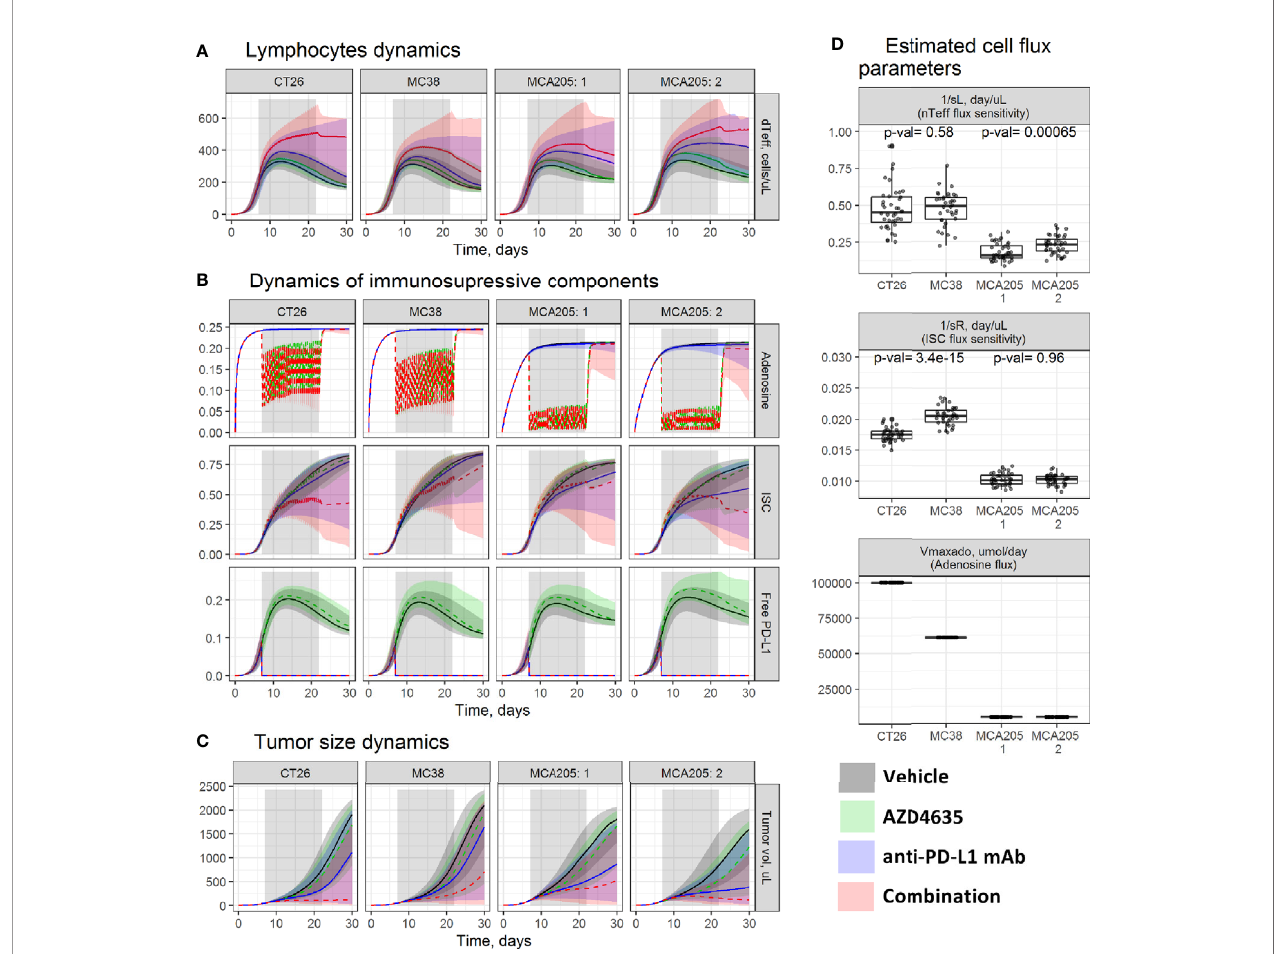
FIGURE 2 | Evaluation of tumor microenvironment (TME) dynamics across experiments. Model-based simulations of (A) dTeff; (B) key immunosuppressive TME components; and (C) tumor size dynamics across studies. Lines — median prediction, area — 90% prediction interval (PI). Different treatment regimens are shown by color. (D) Boxplots of the estimated parameters across studies. P-values were calculated using the Wilcoxon test. MCA205 experiments: 1 — an ef fi cacy study; 2 — a dose- fi nding